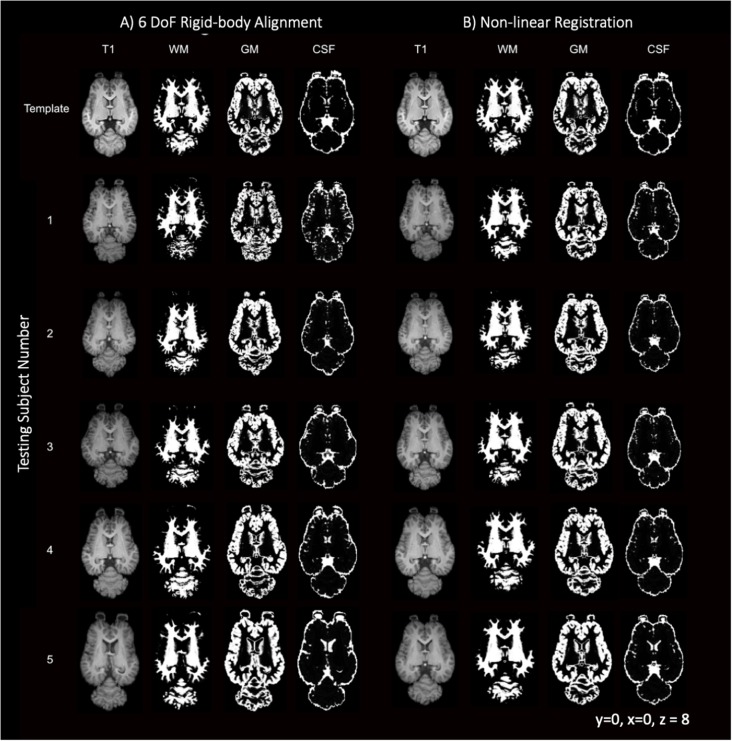
T1-weighted, GM, WM and CSF slices of the template and each individual testing subject. (A) Demonstrates the template (top row) and each of the five testing individuals after 6 degrees of freedom (DoF) rigid body alignment to the template. (B) Demonstrates the template (top row) and each of the testing individual subjects after non-linear registration to the template.